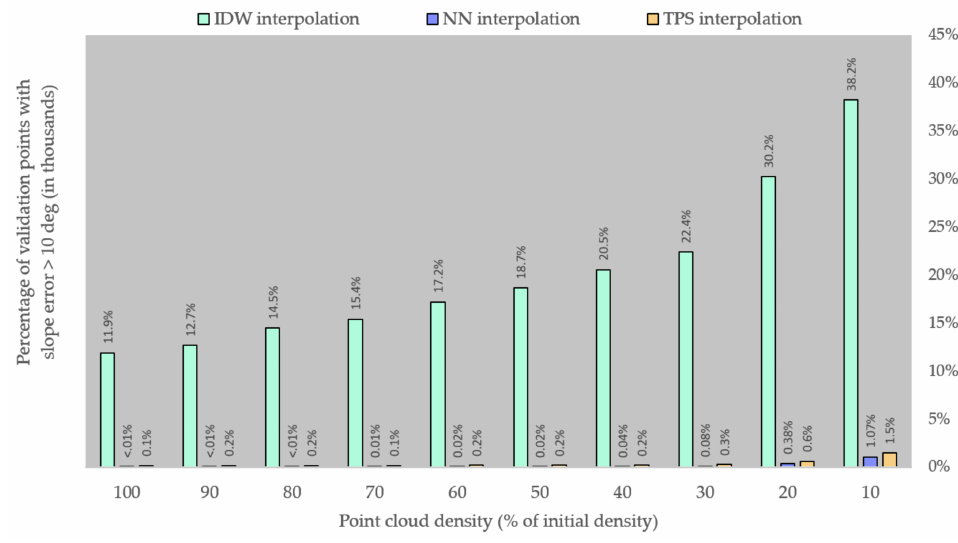
Figure 10. Number of validation points with a slope error over the 10-degree